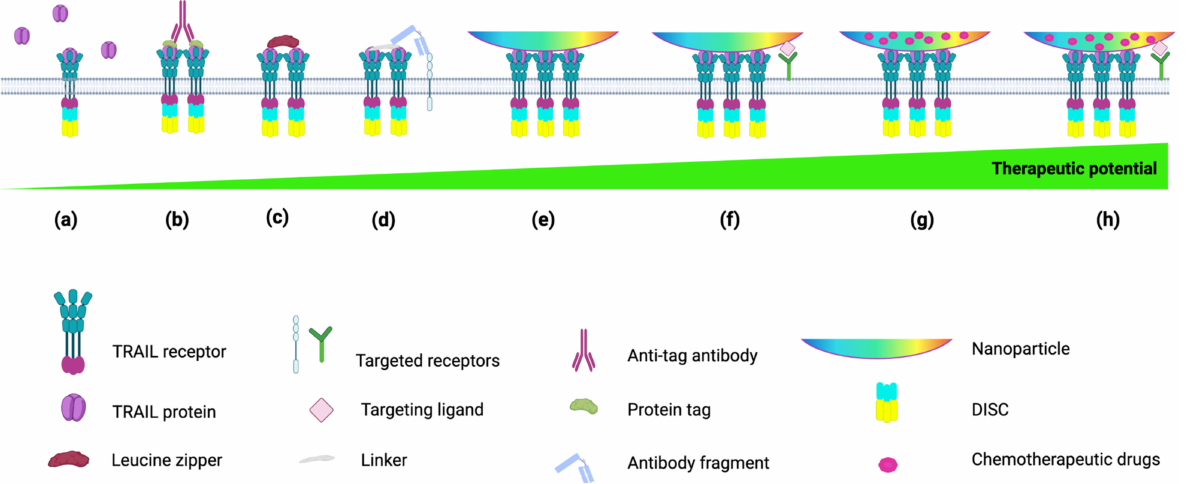
Figure 2. Correlation between TRAIL formulations and anticancer therapeutic potential. ( a ) RhTRAIL- based therapy, ( b ) crosslinking TRAIL monomers through an anti-tag antibody or ( c ) protein fusions facilitating TRAIL oligomerization (i.e., leucine zipper-TRAIL) [5,133]. ( d ) Conjugation of antibody fragment to TRAIL using a linker (i.e., scFv425) [86] to target tumor cells. ( e ) Conjugation of TRAIL to nanoparticles (NPs) to mimic membrane-bound TRAIL, ( f ) additional functionalization of the NPs with antibodies or other molecules to target cancer cells or tumor sites. ( g ) Encapsulation of chemotherapeutic agents into TRAIL-functionalized NPs and ( h ) further modification of NPs surface with molecules or antibodies for active targeting. Figure was generated with